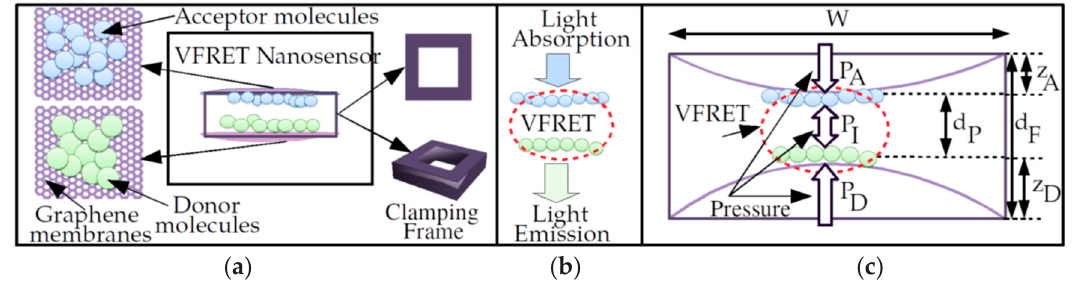
Figure 7. ( a ) Nanoscale sensor design based on VFRET with two graphene membranes clamped on a frame where donors and acceptors are inside a cage of impermeable graphene layers, ( b ) absorption of light by donors at the frequency of donor excitation and emission from acceptor after VFRET between donors and acceptors and ( c ) pressure dependent variation in inter-membrane distance [6,14,15].